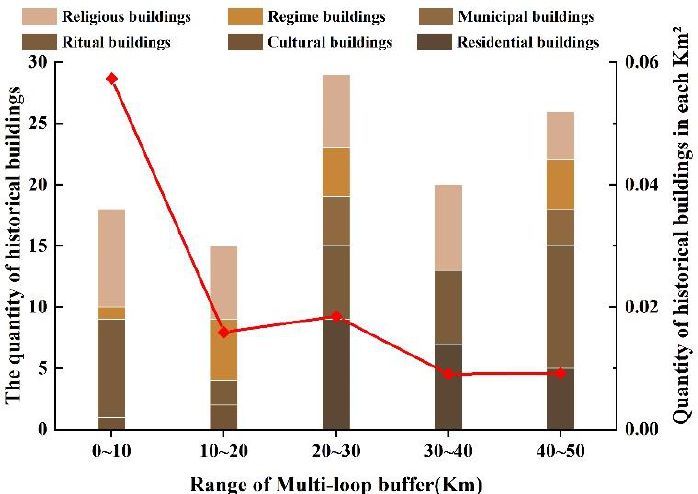
Figure 16. Quantity of each type of historical building distributed at different distances from Mount Song ( ≤ 50 km).